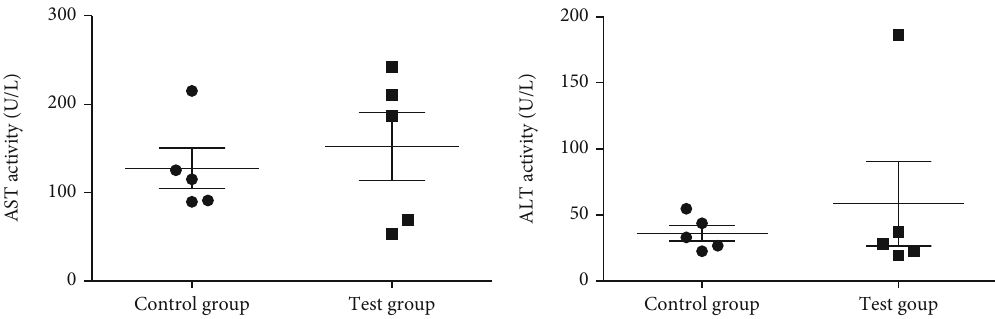
Figure 3: E ff ect of 2000 mg/kg hexane extract of Parmotrema tinctorum on mouse liver enzyme activity. AST: aspartate aminotransferase ( P = 0 : 59 ); ALT: alanine aminotransferase ( P = 0 : 52